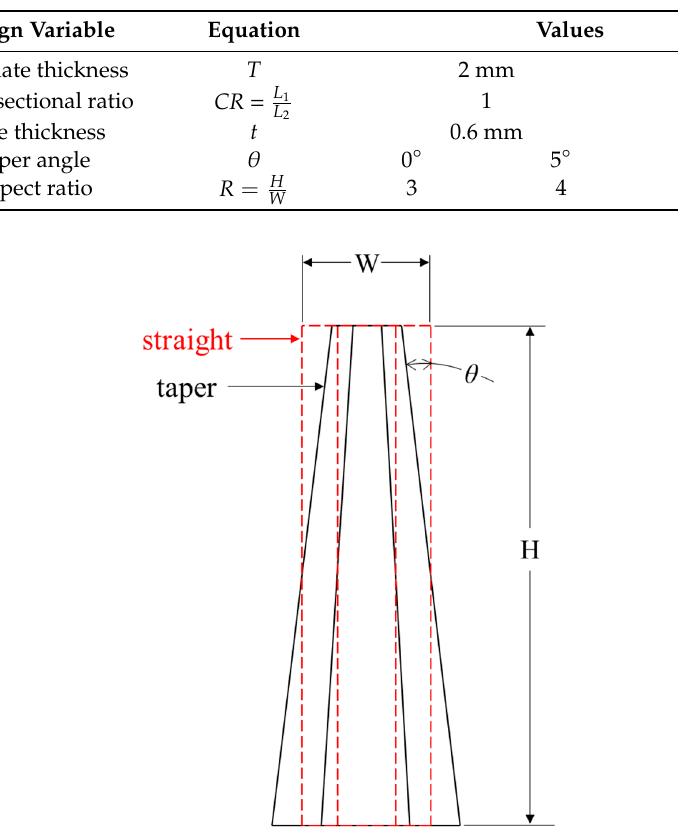
Figure 3. Mild steel straight to taper tube superimposition.